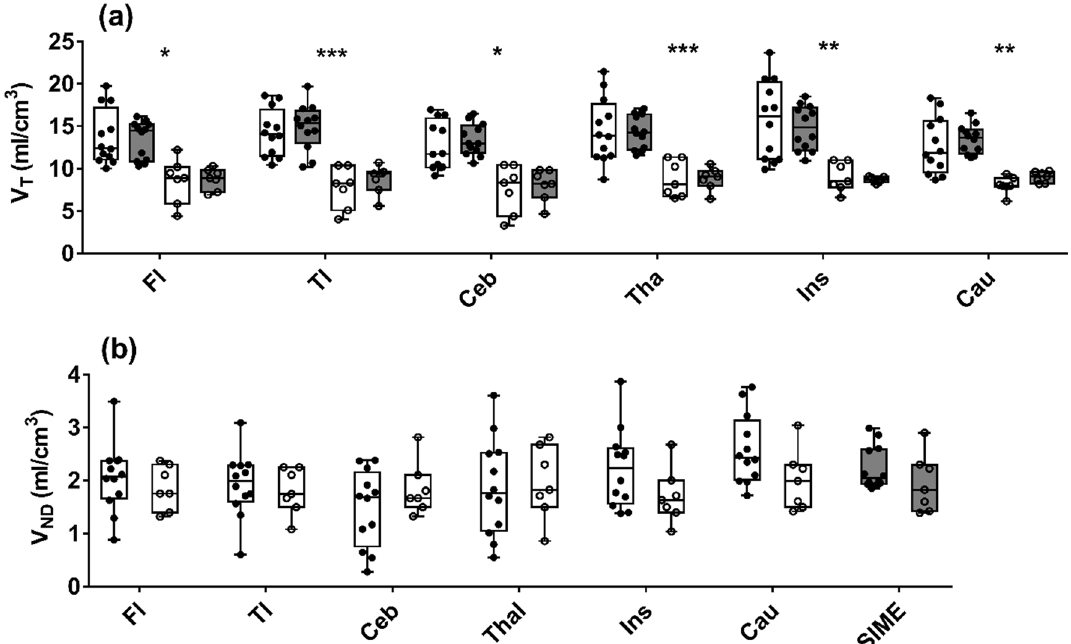
Fig. 1 a Regional V T estimates from the 2TCM (open box plots) and SIME (gray box plots). b Corresponding estimates of regional V ND from the 2TCM and common V ND from SIME. Results have been separated into HABs (filled circles) and MABs (open circles). Frontal lobe: Fl, Temporal lobe: Tl, Cerebellum: Ceb, Thalamus: Thal, Insula: Ins, and Caudate: Cau. Data are presented as box–whisker plots with the median indicated by the black line. Significant between HABs and MABs are indicated by asterisk (* p < 0.05, ** p < 0.01 and *** p <